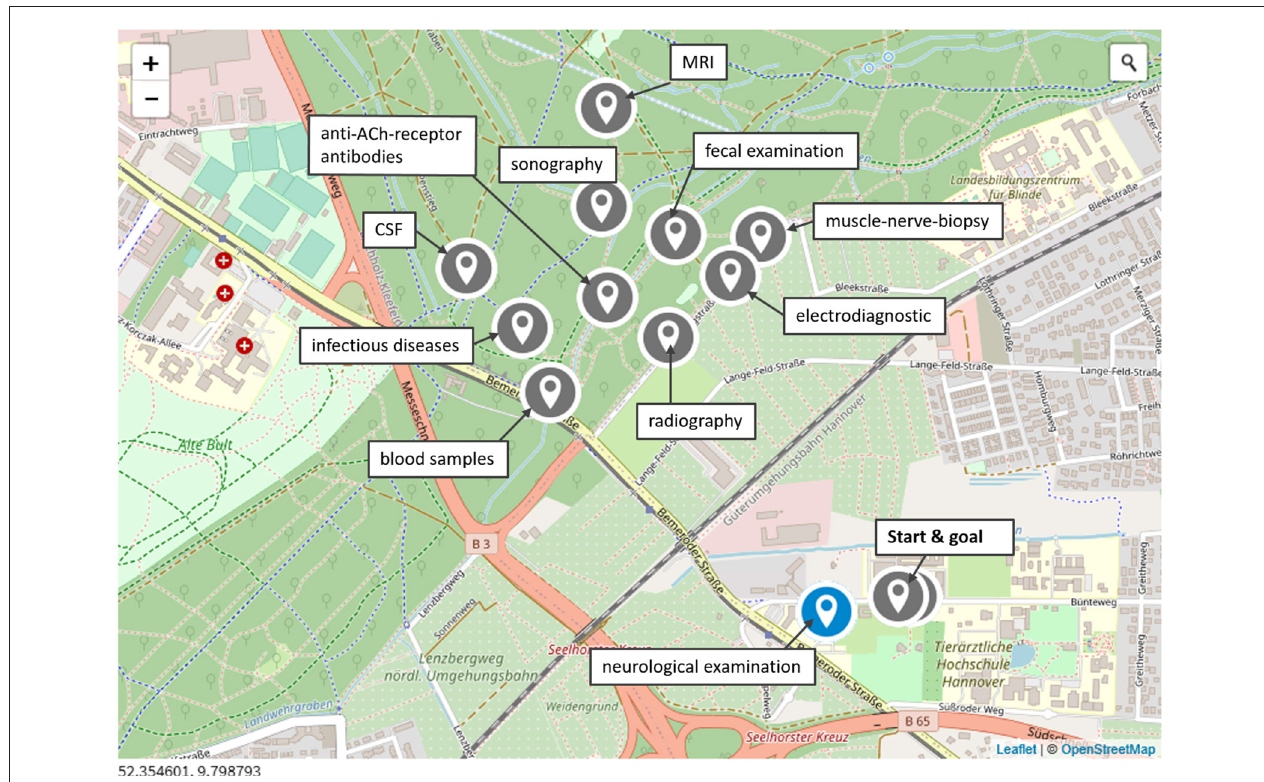
FIGURE 1 | Map. Case of the tetraparetic Australian Shepherd. Map of Hannover, Germany. Every section of the bound is connected with a single examination and guides the students via the global positioning system (GPS) to another geographical localization on the campus and the surrounding forest. MRI, magnetic resonance imaging; CSF, cerebrospinal fluid; ACh, acetylcholine. Modified from Actionbound (6).